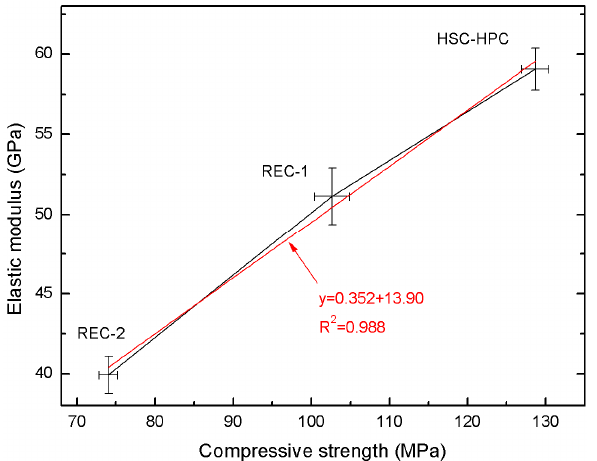
Figure 4. Correlation between compression strength and elastic modulus E of concrete.